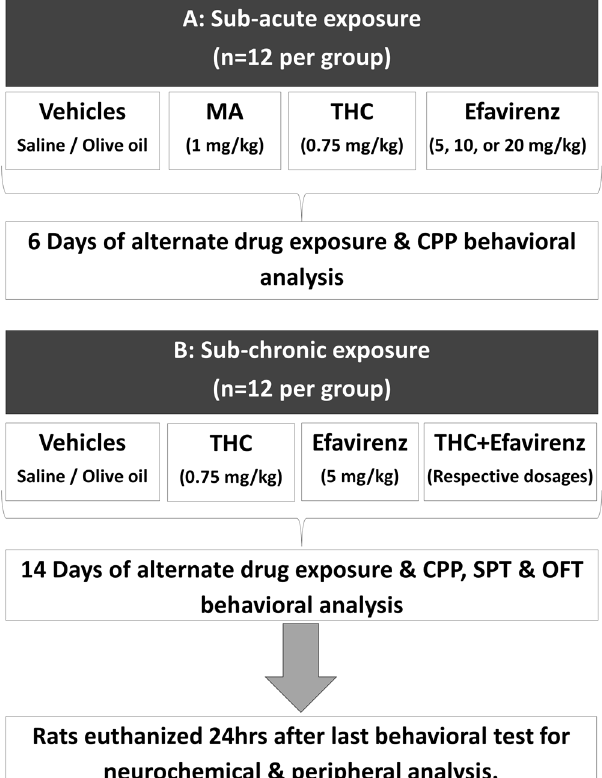
Figure 1. Study design: ( A ) Sub-acute study with 7 groups of rats (n = 12 rats per group) exposed to indicated drugs at alternate day dosing for 6 days and the conditioned place preference (CPP) test performed after 6 days of conditioning. ( B ) Sub-chronic study with 5 groups of rats (n = 12 rats per group) exposed to indicated drugs at alternate day dosing for 14 days during which the CPP test, open field test (OFT) and the sucrose preference test (SPT) were performed. Regional neurochemical analysis was performed in the frontal cortex, striatum and hippocampus and peripheral analysis in the